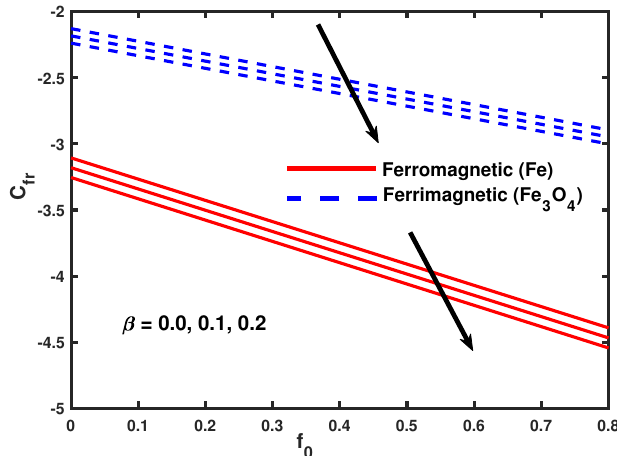
Figure 18. Impact of magnetic nano-particles and ferromagnetic parameter ( β ) on skin friction.